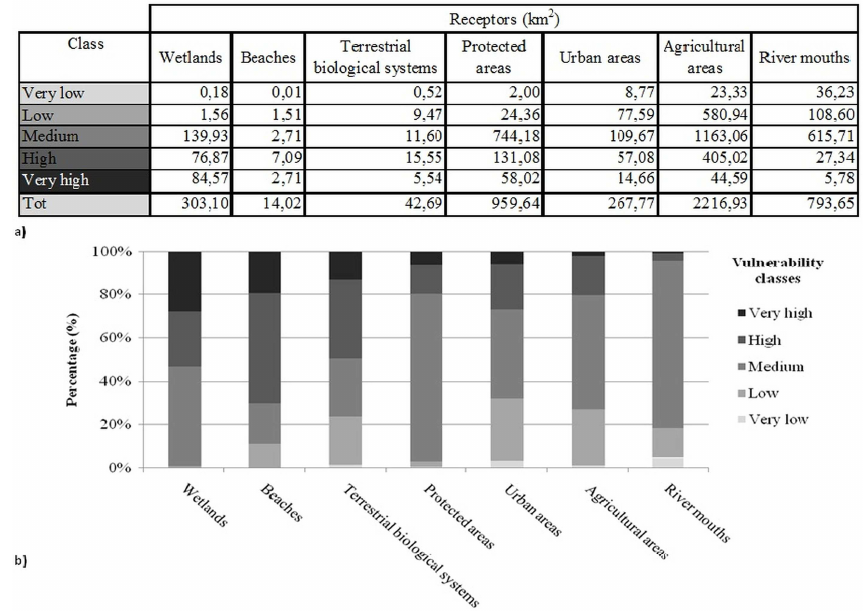
Fig. 7. Distribution of the territorial surface (km 2 ) (a) and of the percentage of surface (b) associated with each vulnerability class for the receptors located on the North Adriatic coast for the storm surge flooding impact.